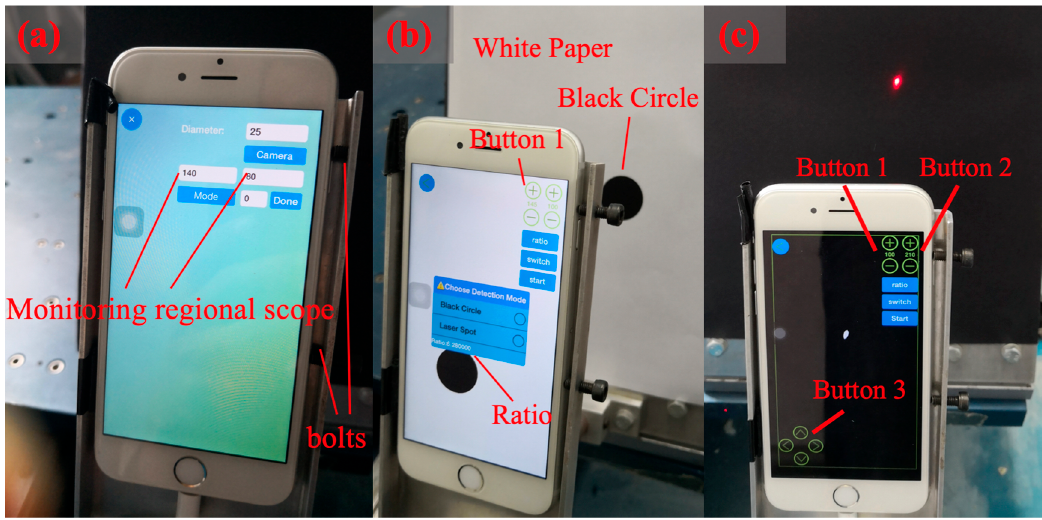
Figure 4. ( a ) Initial setting interface; ( b ) Calibration interface; ( c ) Monitoring interface.